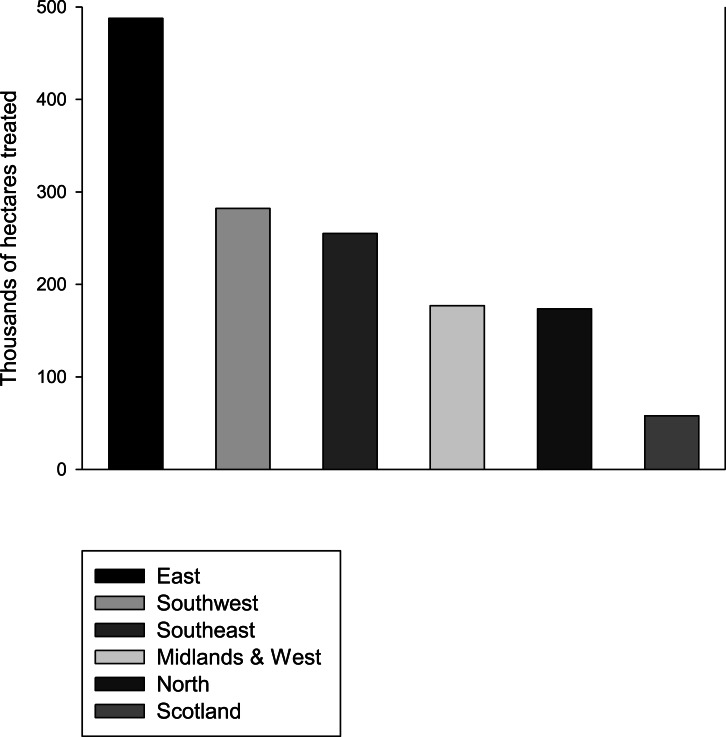
Neonicotinoid usage by region.The area in thousands of hectares treated with neonicotinoids in 2010 in different regions of England and Scotland. Data from Defra (2014).